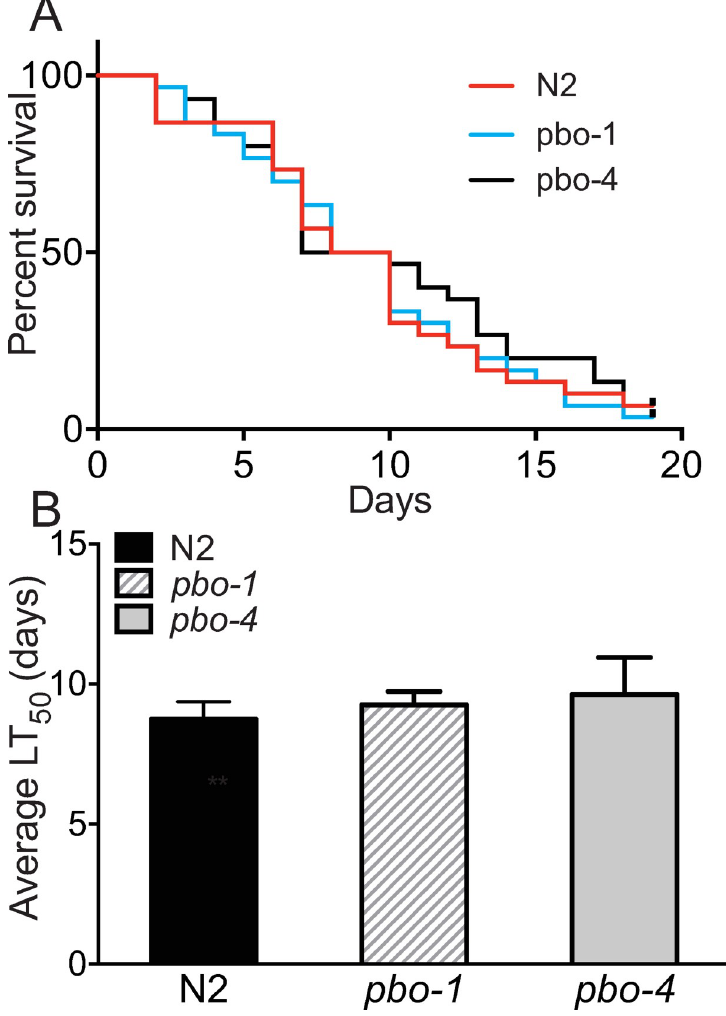
Fig 3. Bicarbonate increases survival of E . faecalis -fed pbo-1 mutants. (A) Survival of wild-type, pbo-1 or pbo-4 mutants fed E . faecalis on nematode growth medium with 25 mM bicarbonate (bicarbonate NGM). In each experiment, 30 worms were placed on bicarbonate NGM with an E . faecalis lawn, and the worms were subsequently transferred every two days to new bicarbonate NGM plates with a fresh E . faecalis lawn and monitored for survival. (B) Average calculated lethal time to kill 50% of animals (LT 50 ) of 3 independent experiments. LT 50 and p values for individual experiments are provided in S2 Table. The average LT 50 of WT was not statistically different from either mutant by student’s t -test ( p >